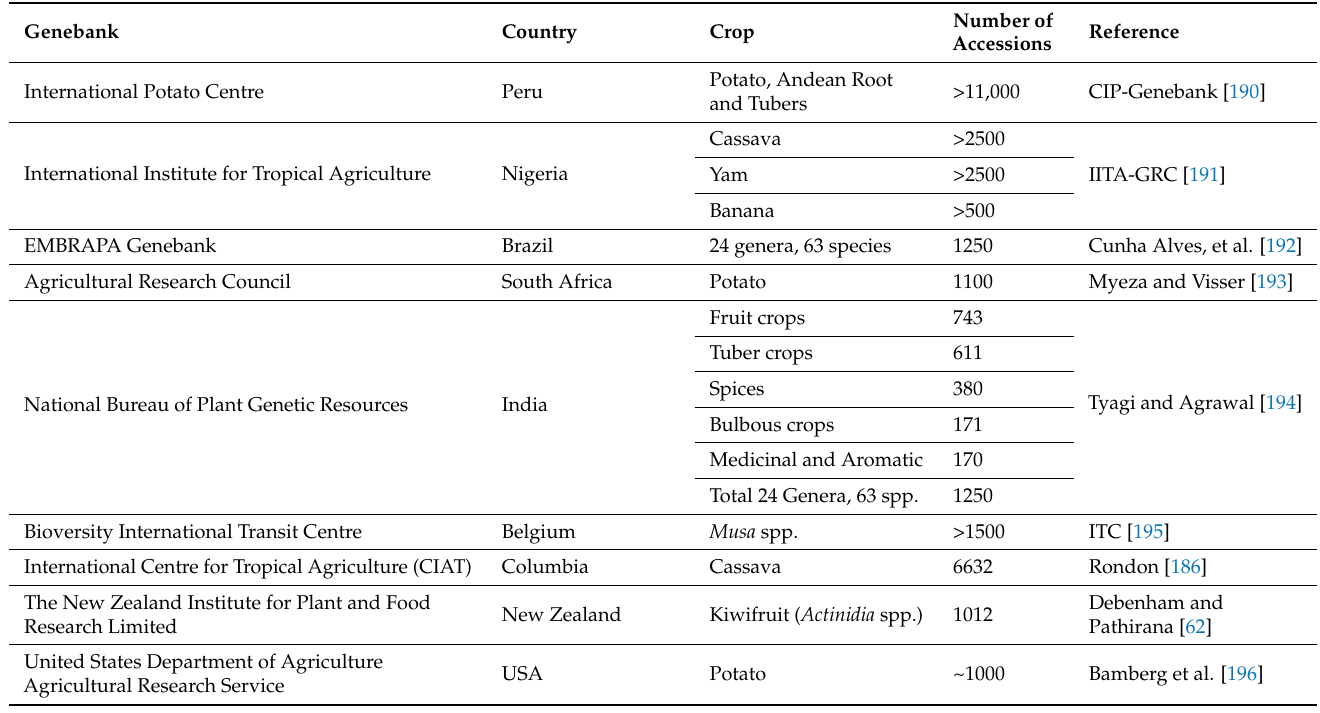
Table 4. Genebanks with large in vitro